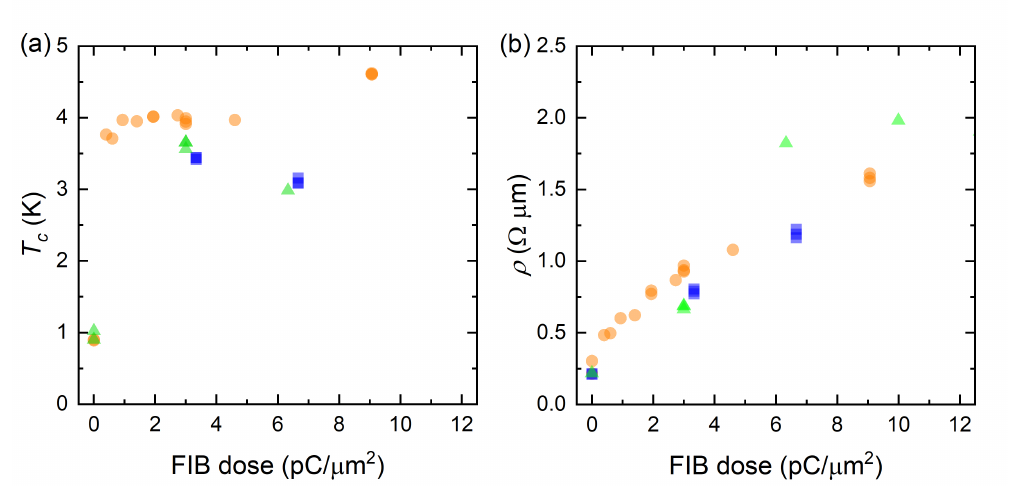
Figure 3. Critical temperature ( a ) and normal state resistivity ( b ) as a function of FIB dose for the uncoated micrometer scale wires (orange circles, see Figure 1b), coated micrometer scale wires (blue